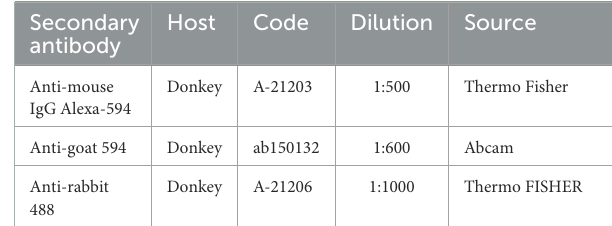
TABLE 3 Secondary antibodies used in the